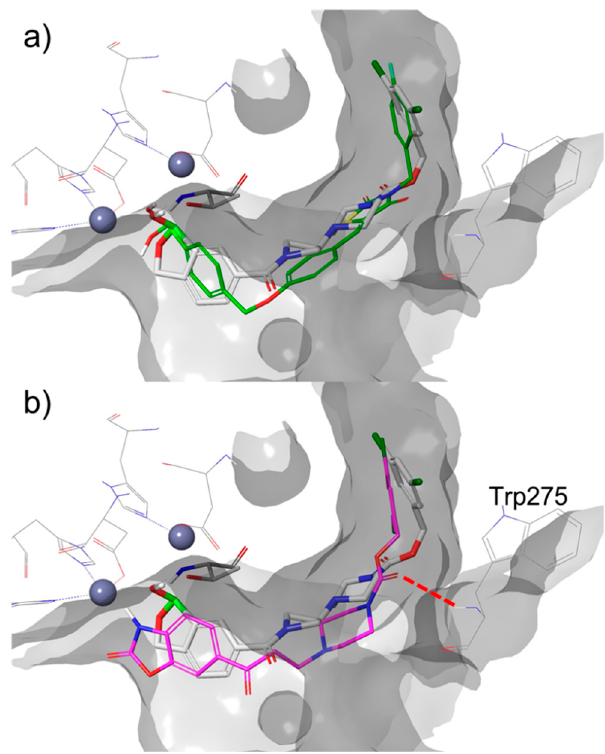
Figure 8. Compound 37 docked in the binding site of ATX using covalent docking and overlapped with ligands from x-ray structures: ( a ) HA155 boronic acid inhibitor (green, PDB ID: 2XRG) [9]; ( b ) PF-8380 (magenta, PDB ID: 5L0K [21]).